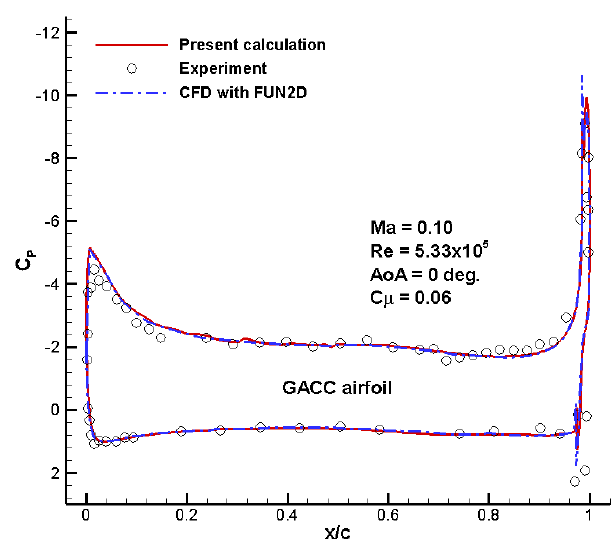
Figure 6. Pressure coefficient distributions.